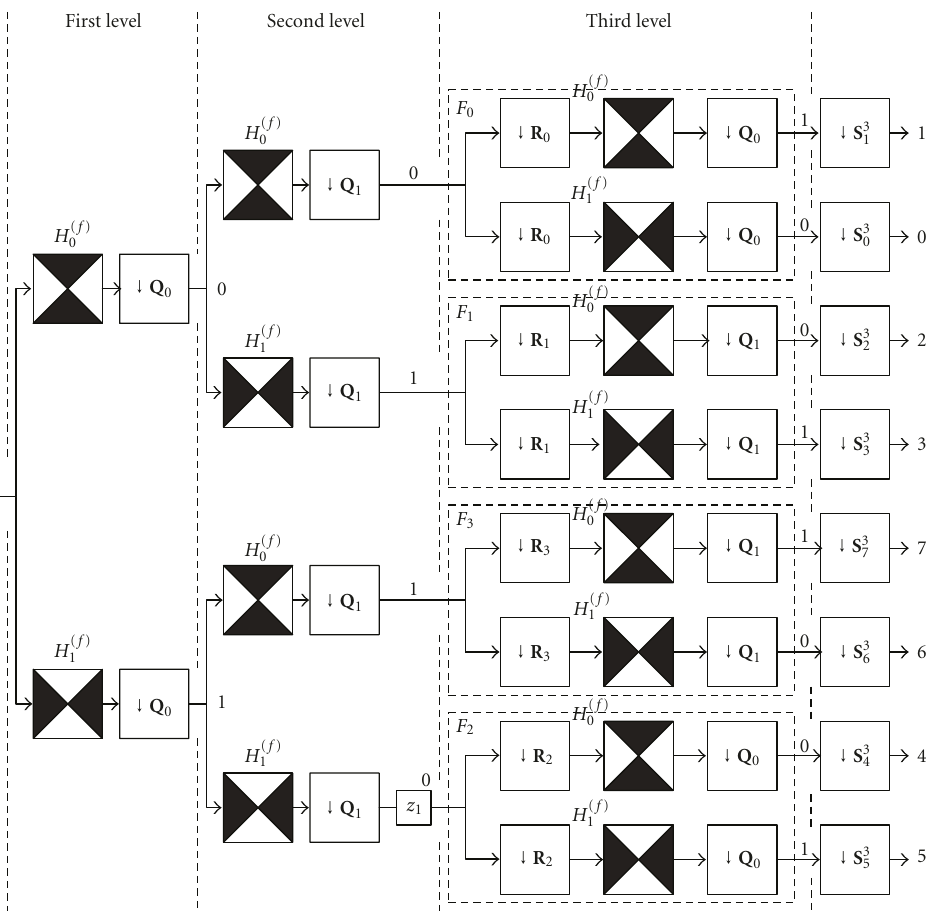
Figure 2: The iterative tree structure for the conventional DFB